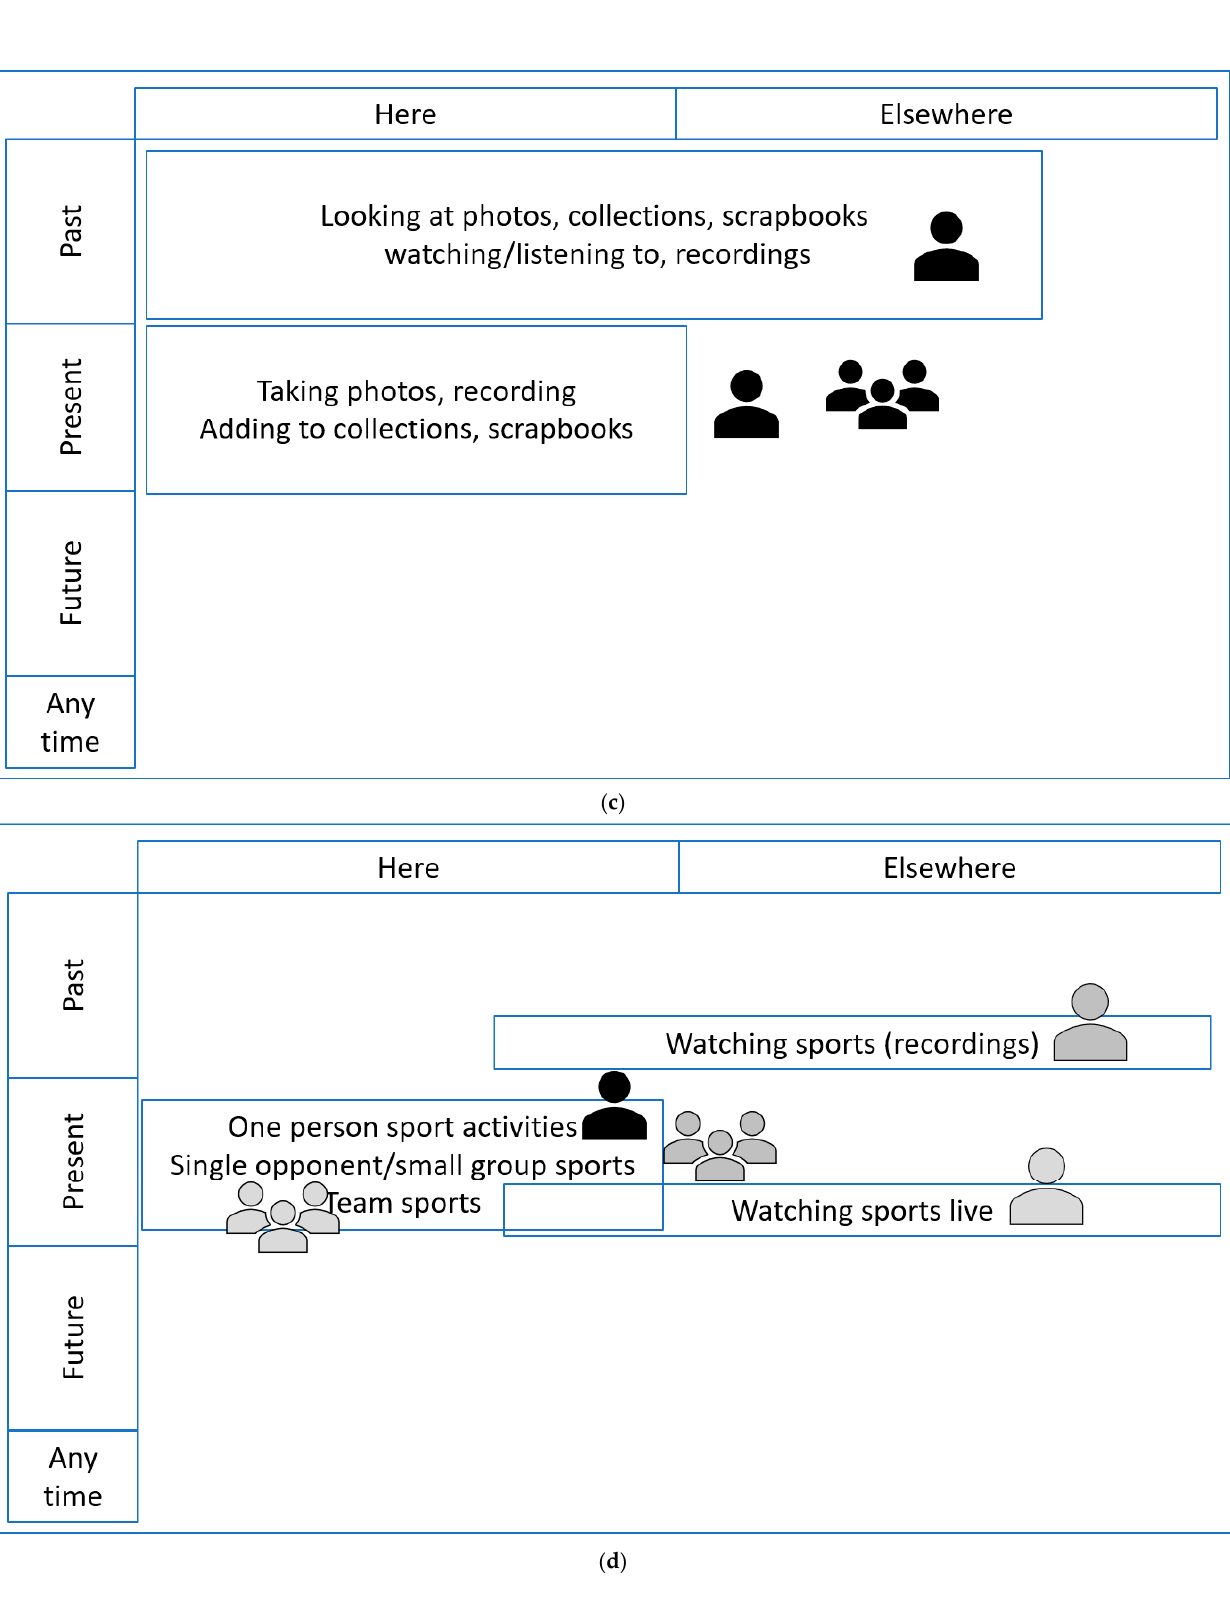
Figure 3. ( a – d ) A classification of leisure activities according to their temporal, spatial, and social